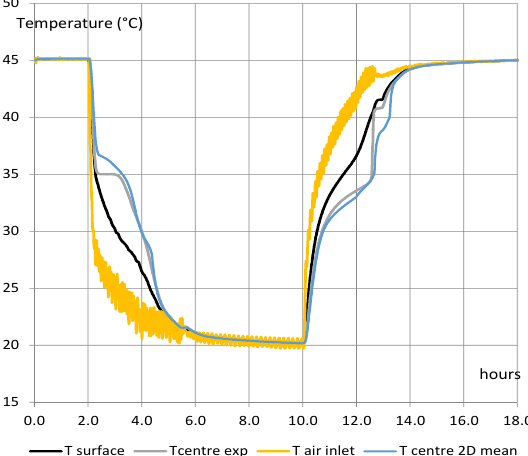
Figure 20. Comparison of measured and calculated temperature variation at the centre of the container comparison showing the mean of the modelled values and experiment results.